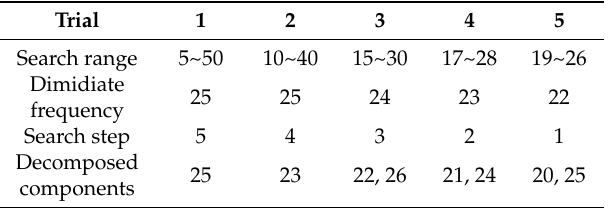
Table 1. Influence of the parameters on the performance of